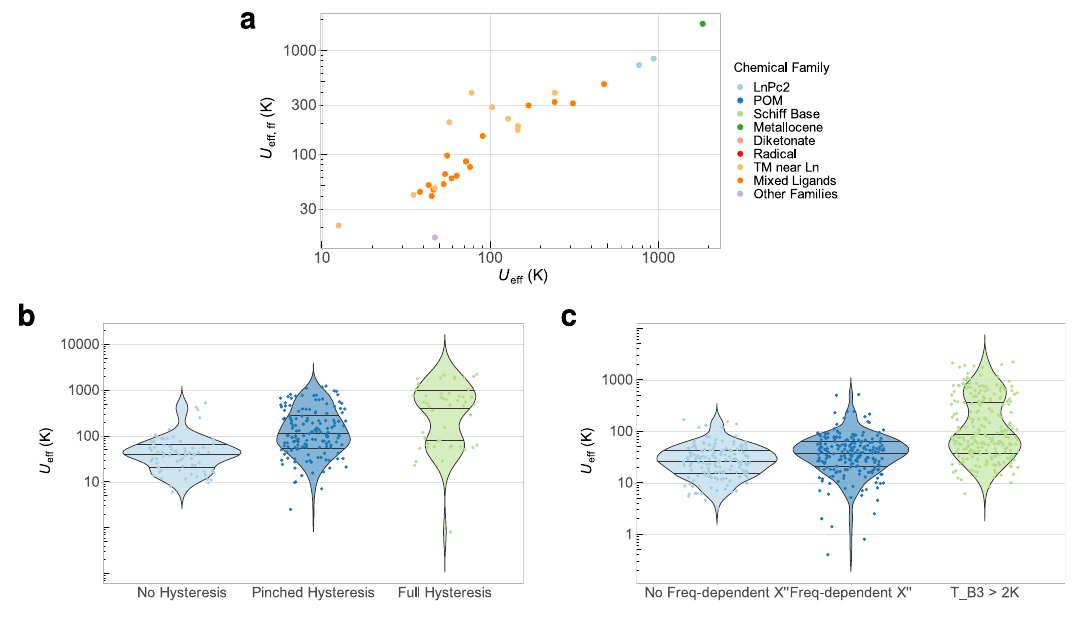
Fig. 4 | Main dependencies between the physical variables. a Dependence between U eff and U eff,ff . b Distribution of U eff for samples depending on their qualitative hysteresis behaviour, c Distribution of U eff for samples depending